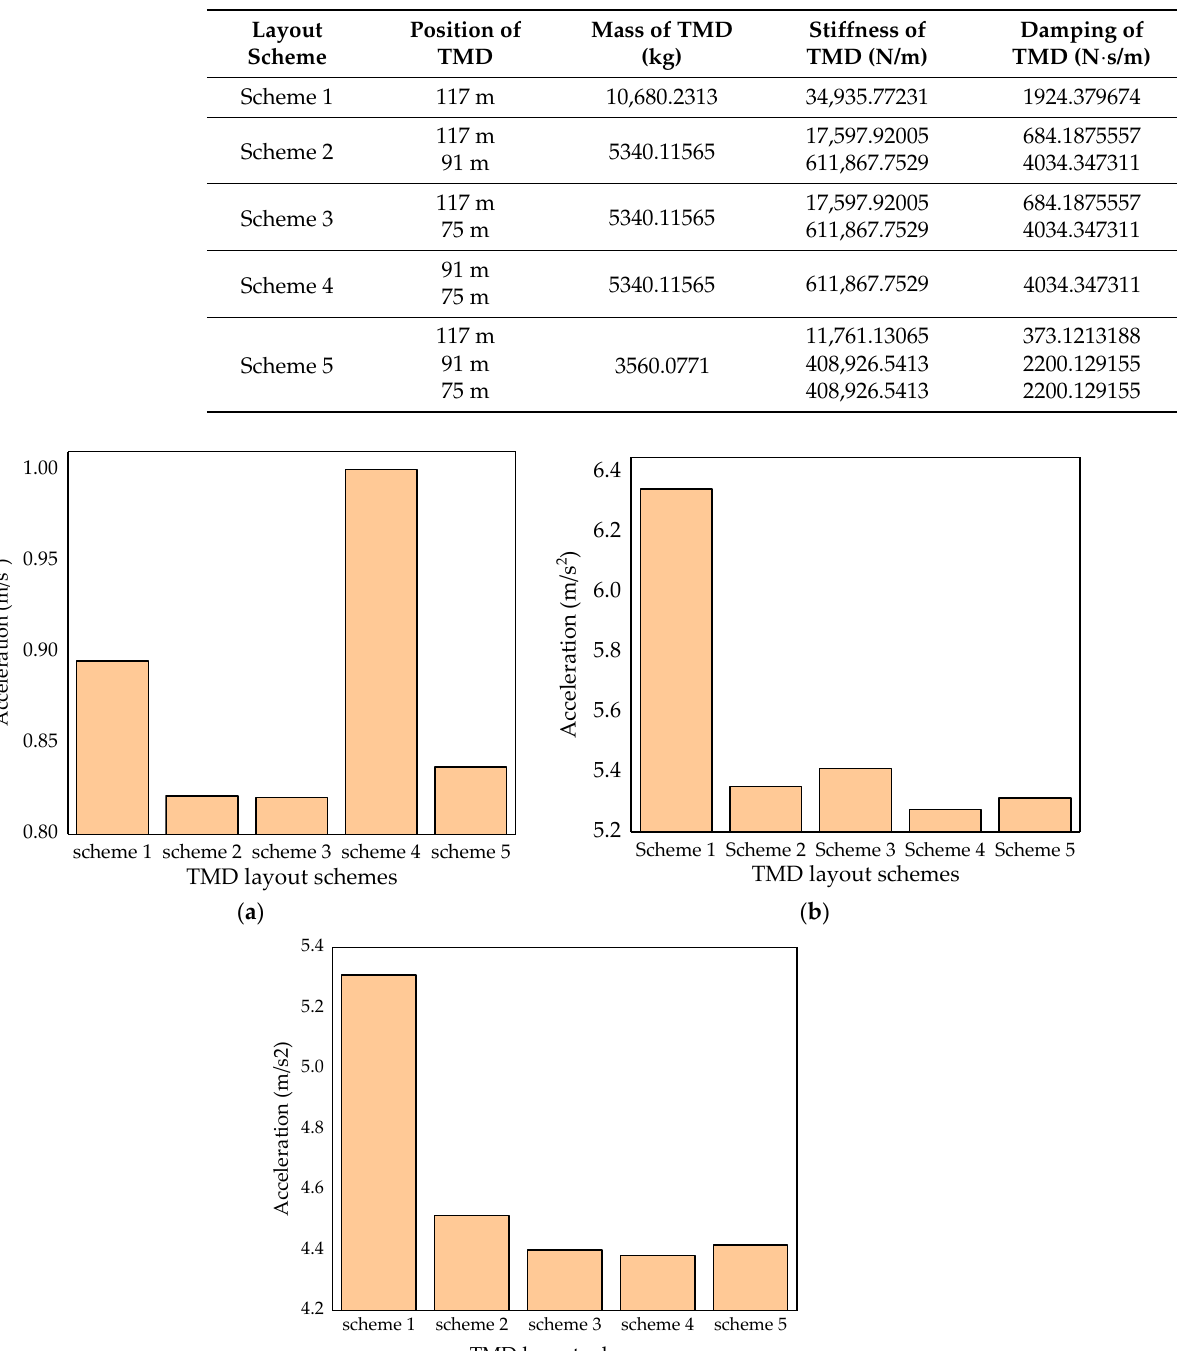
Table 4. TMD-specific parameters of different layout schemes.